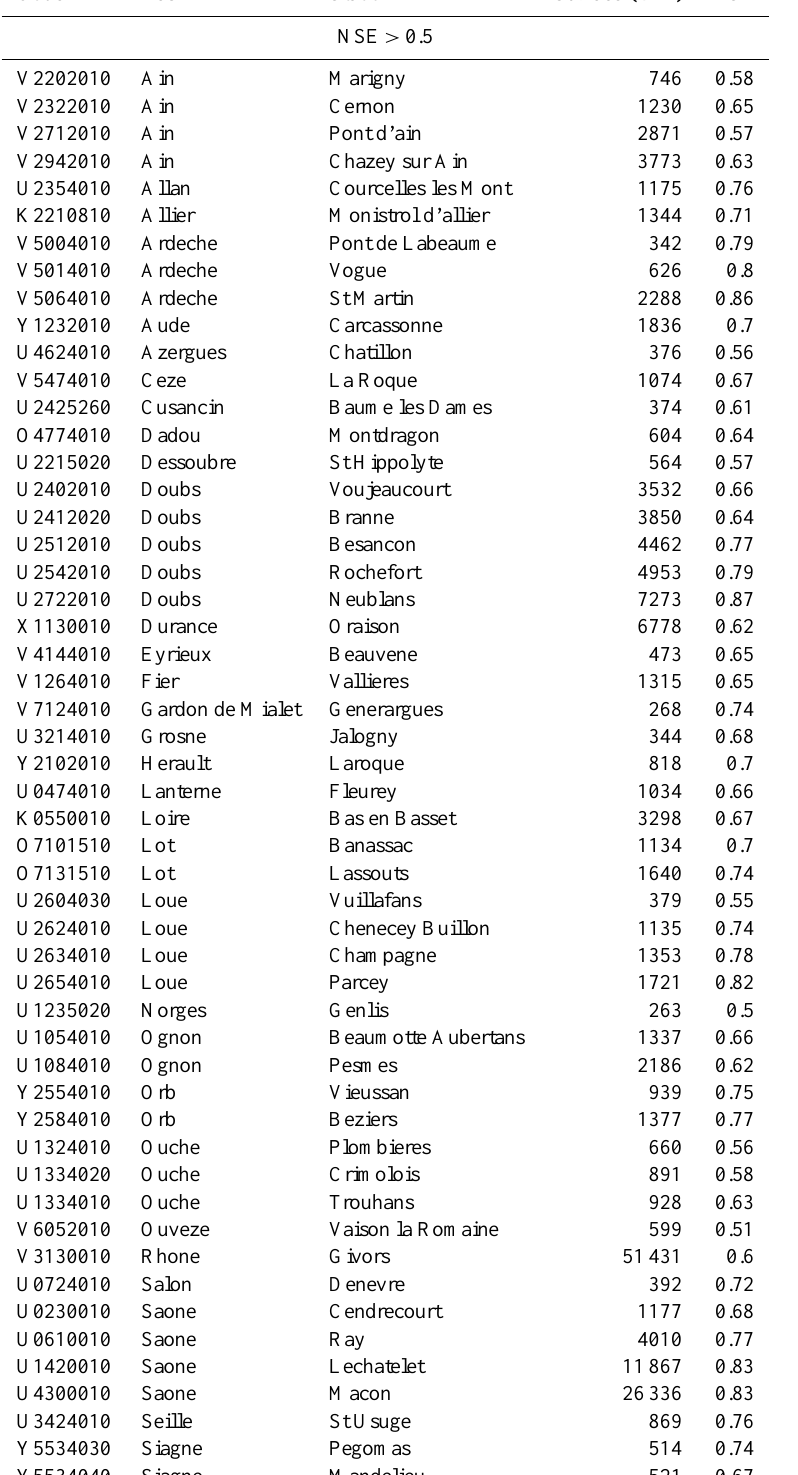
Table A1. Gauging stations used to validate the simulated river discharge. The stations are divided into two blocks, according to the model’s